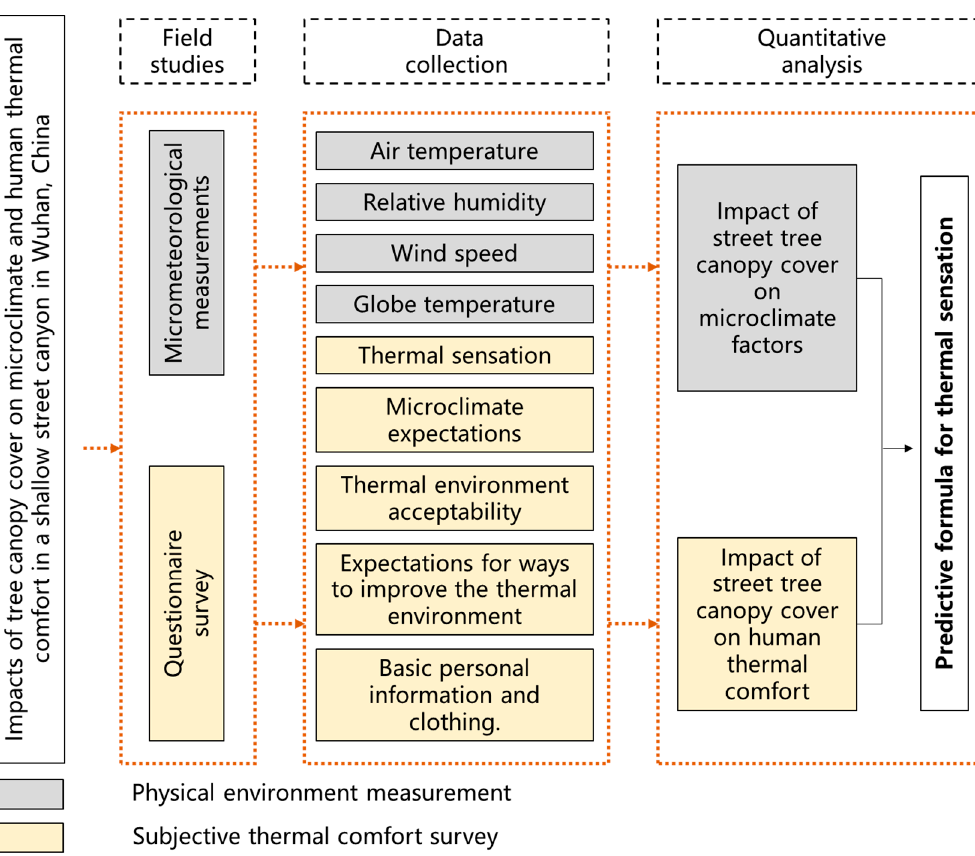
Figure 1. Flow chart of research framework.